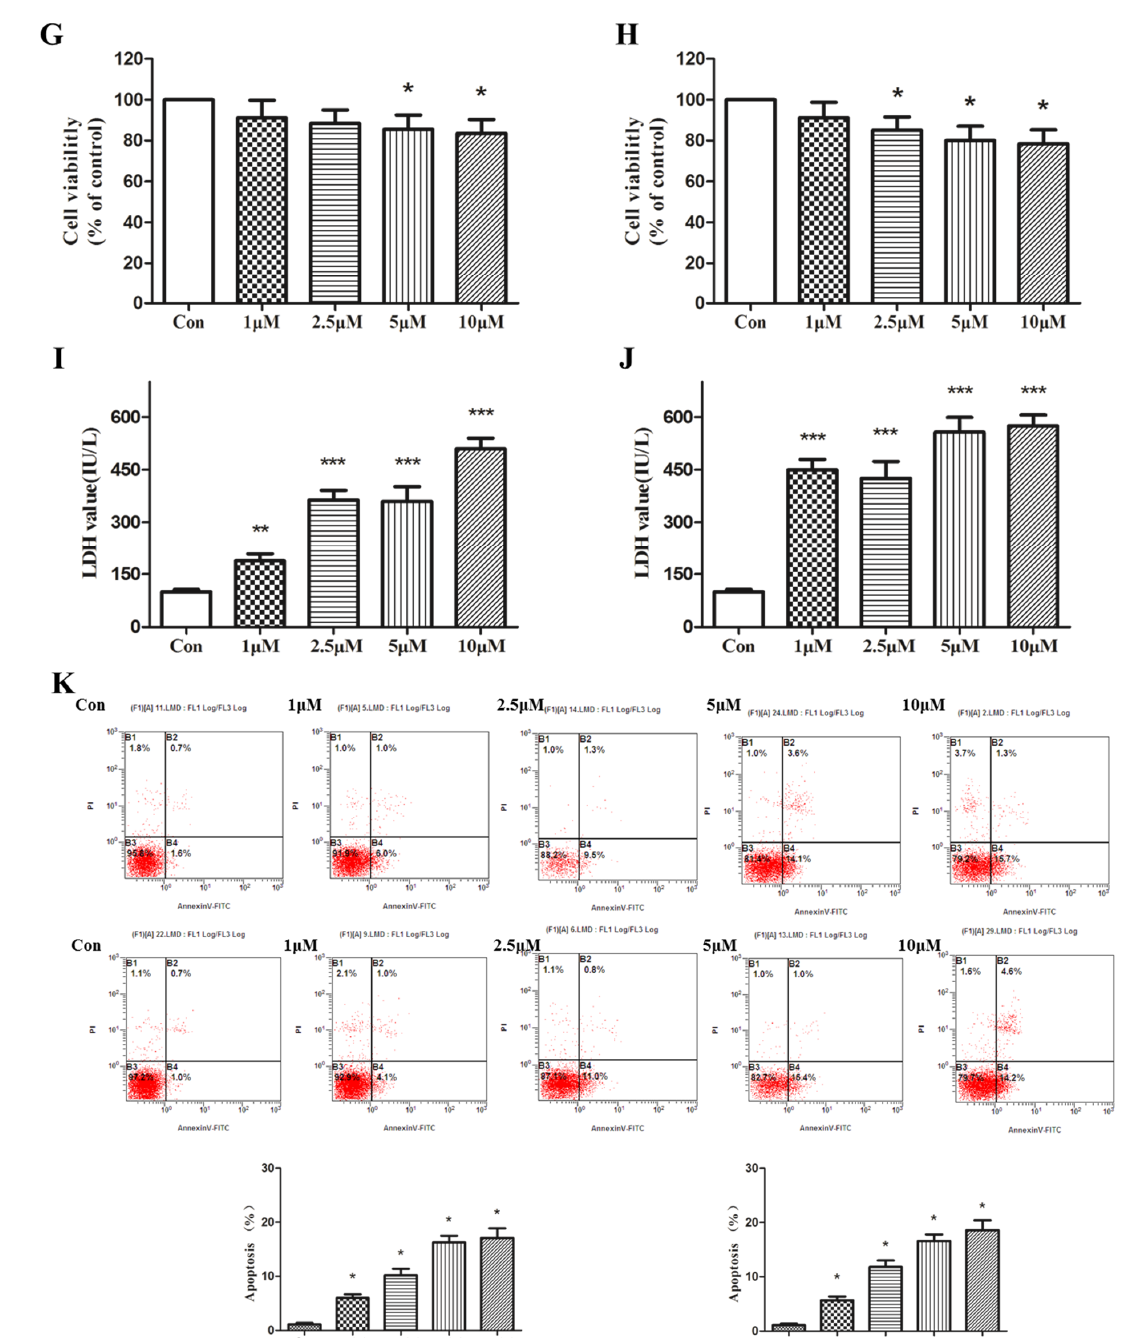
Figure 1. Pb exposure leads to neurotoxicity. Rats were given different doses of lead acetate in water for 8 weeks. After Pb exposure, levels of Pb in the blood ( A ) and brain ( B ) were determined by an atomic absorption spectrophotometer. The Morris water maze was used to measure the effect of Pb exposure on spatial learning and memory capacity in rats ( C , D ). Lead acetate (0, 1 uM, 2.5 uM, 5 uM, and 10 uM) was dissolved in DMEM and Neuron Basal culture medium. Primary hippocampal neurons were exposed to different concentrations of lead acetate for 12 h and 24 h. The effect of Pb on cell viability was determined by MTT ( E , F ). PC12 cells were exposed to different concentrations of lead acetate for 12 h and 24 h. The effect of Pb on cell viability was determined by MTT ( G , H ) and LDH ( I , J ) assay, and apoptosis was evaluated using flow cytometry ( K ). The data are expressed as mean ± SD of three independent experimtents. * p < 0.05, ** p < 0.01 and *** p < 0.001 compared with control